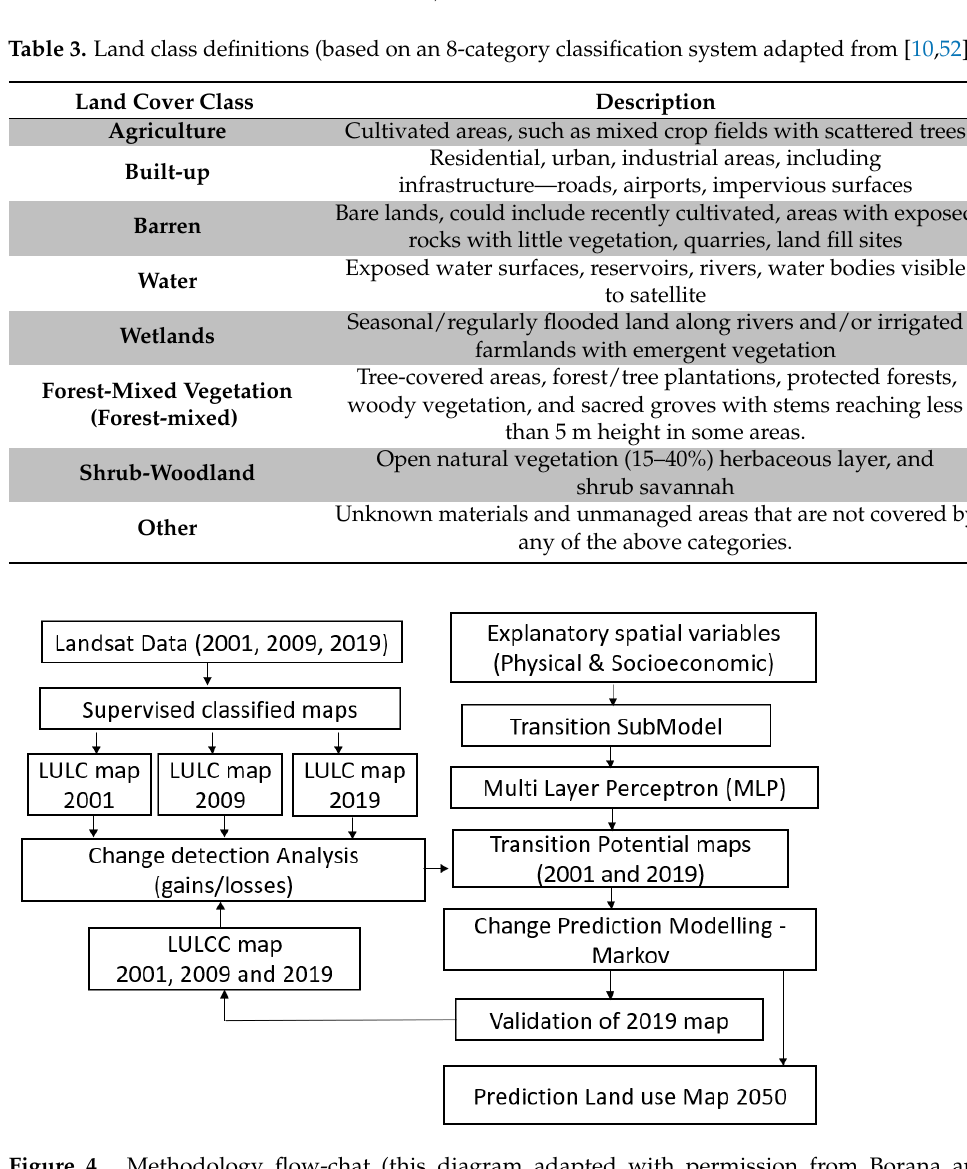
Figure 4. Methodology flow-chat (this diagram adapted with permission from Borana and Yadav